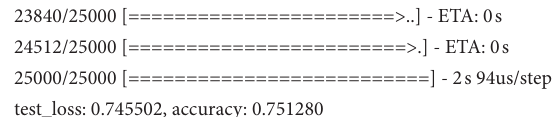
Figure 17: Average accuracy of models on multimodal fusion database.